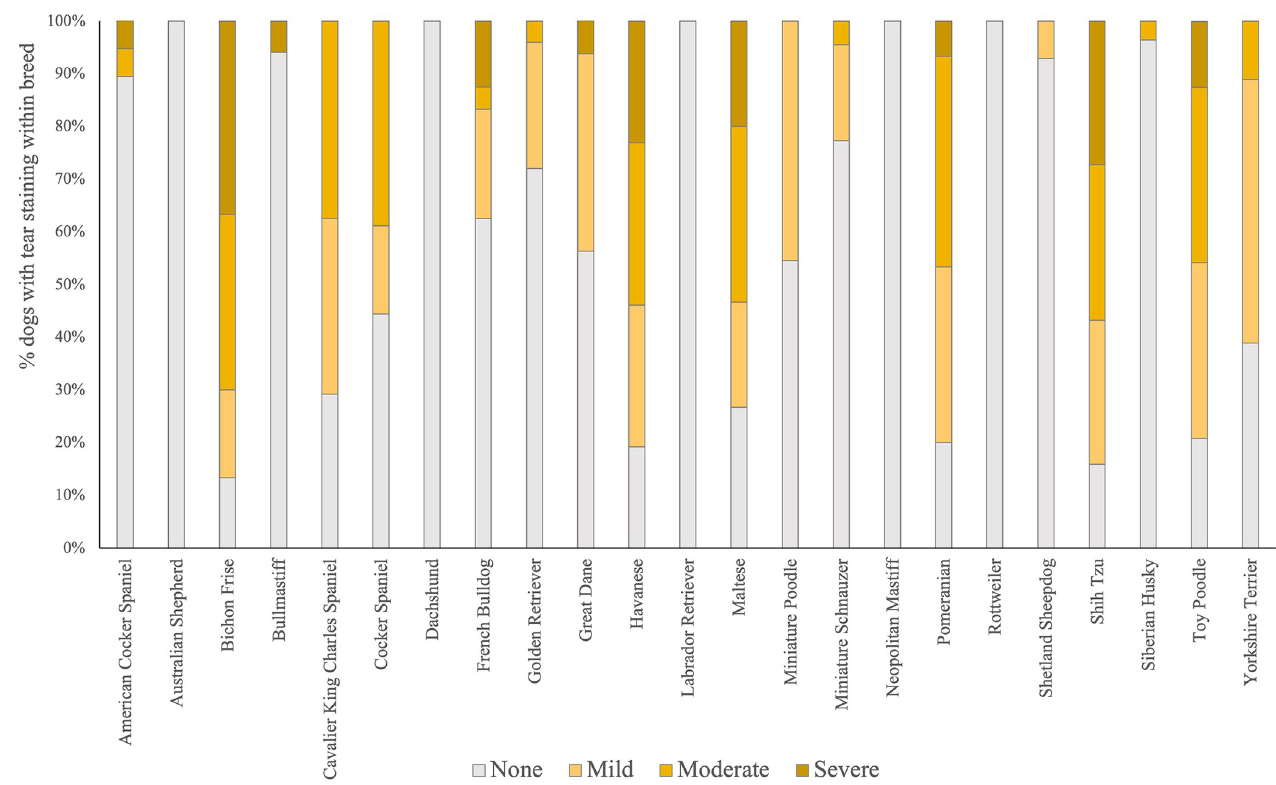
Fig 3. Tear staining severity by breed. Percentage of dogs (within breed) showing different levels of tear staining (i.e., none, mild, moderate or severe). Note: only breeds in our sampled population with more than 10 individuals are presented here (n = 502), see S1 Table in S1 File for reference of sampled breeds.